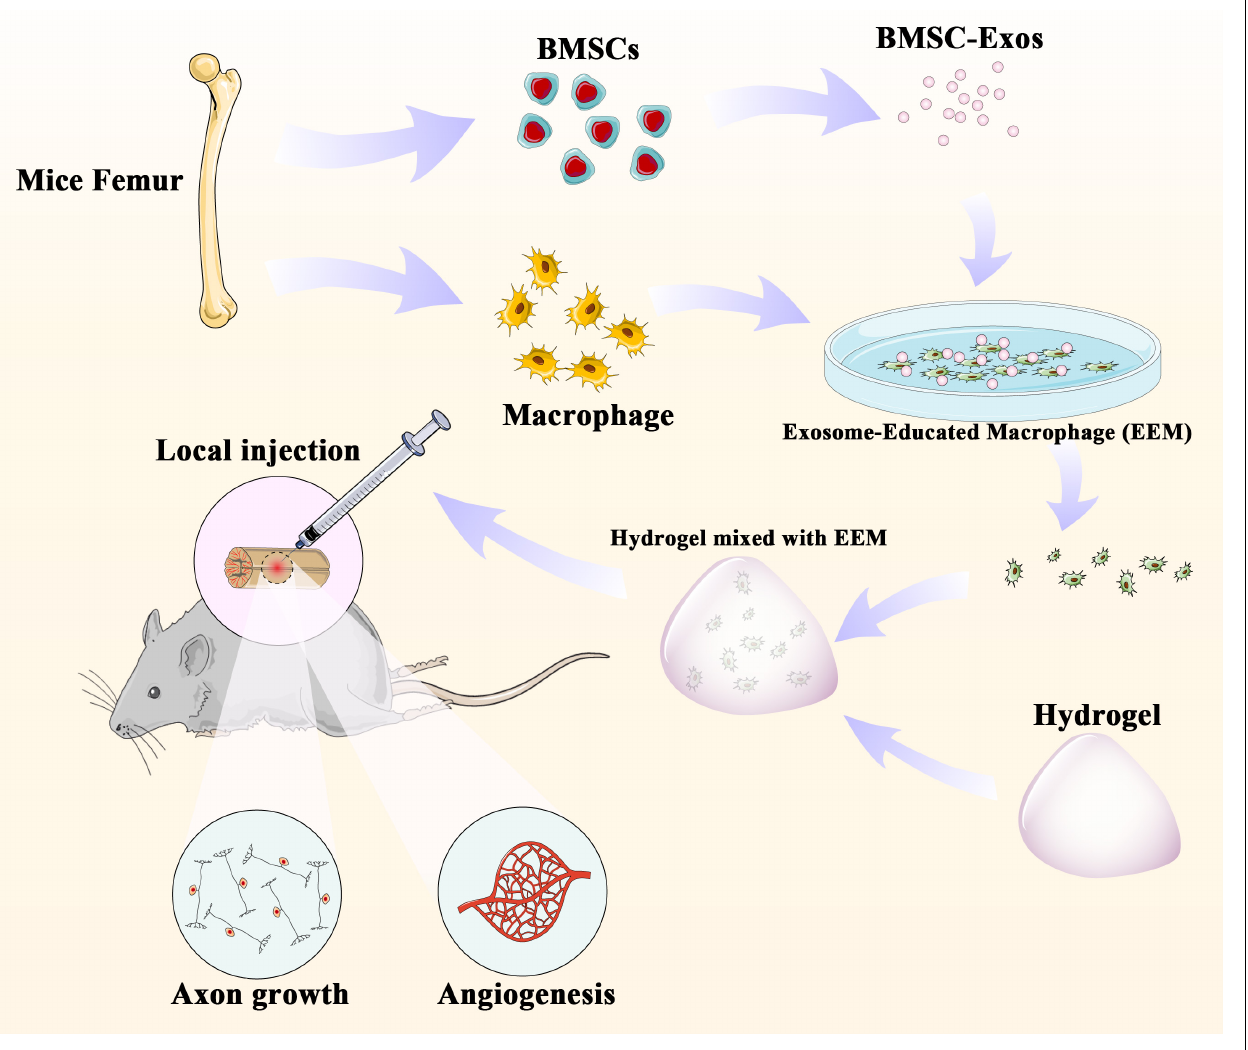
FIGURE 7 | BMSC-derived exosomes extracted from mouse femurs were cultured with macrophages to obtain exosome-educated macrophages (EEM). EEM and hydrogel were mixed and applied to the surface of the injured spinal cord to promote axonal regeneration and